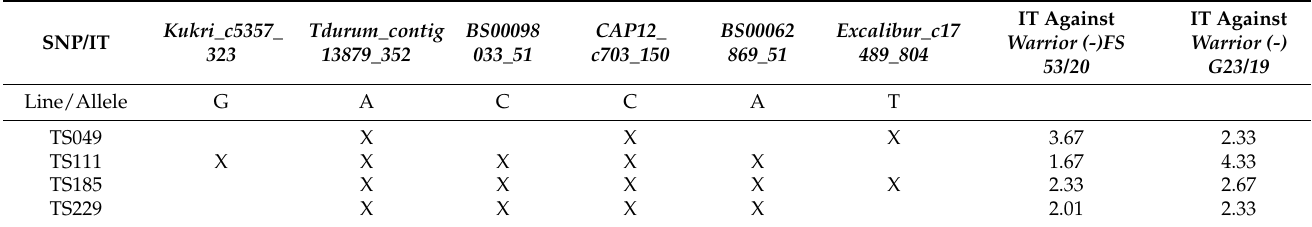
Table 2. The resistant lines contained at least 3 alleles (shown by X) of 6 significant SNP sites identified by GWAS at the seedling stage for the IT means of the Pst